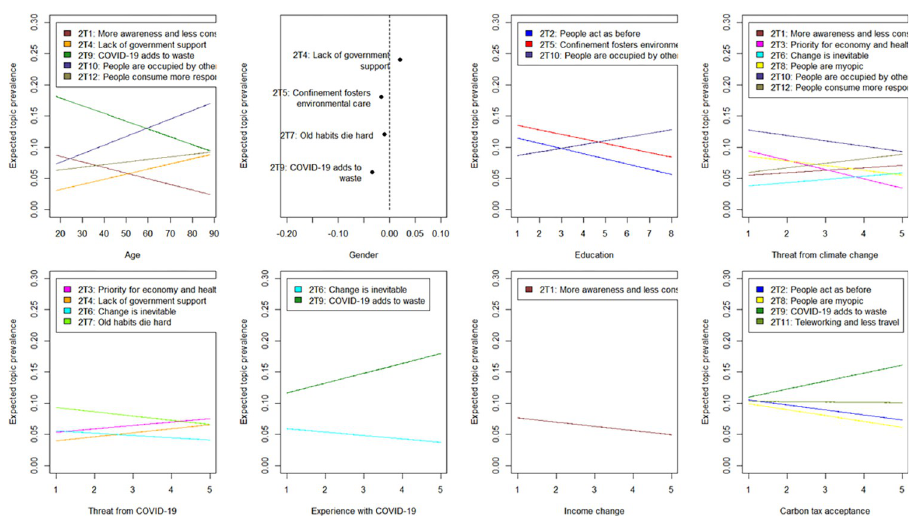
Fig 2. Effect of covariates on topic prevalence for thoughts on people’s climate action. Note: Point estimates of selected covariates on topic prevalence are plotted holding all other covariates constant. The plot for gender shows mean difference in topic proportions between male and female (a positive value on the X-axis indicates a larger prevalence for male respondents). Only results significant at least the 1% level are displayed. Results for all topics are available in S6 Table in S1